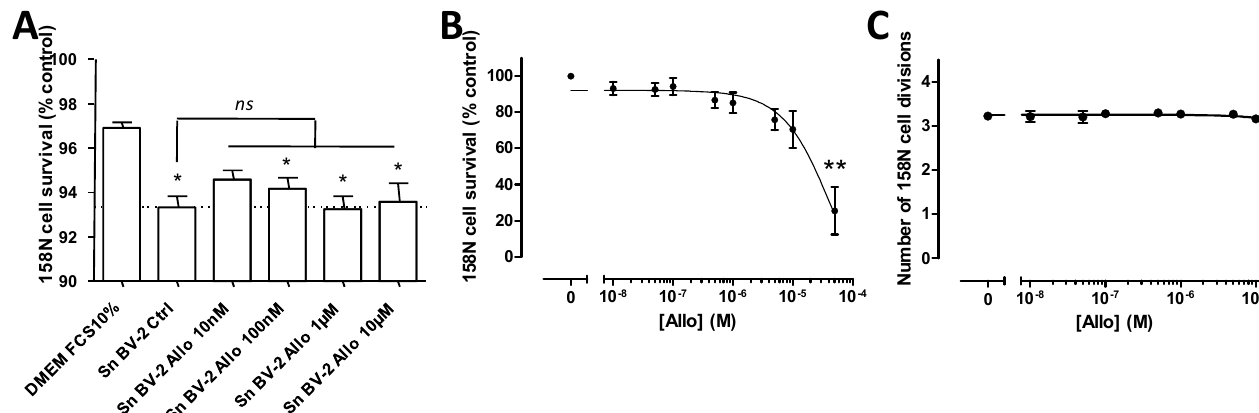
Figure 6. Effect of ALLO on reactive BV-2 cell derived supernatants in the modulation of oligodendrocyte survival. ( A ) The incubation of BV-2 with graded concentrations of ALLO from 10 nM to 10 µM did not modify the toxicity of their supernatants towards the oligodendrocyte 158N cell line. Mean values ± SEM are shown, from n = 4 independent experiments, * p < 0.05 versus ‘DMEM FCS10%’, ns : non-significant. ( B ) The effect of graded concentrations of ALLO on the viability and ( C ) on the proliferation of the 158N cells. Mean values ± SEM are shown, from n = 3–4 independent experiments, * p < 0.05, ** p < 0.01.